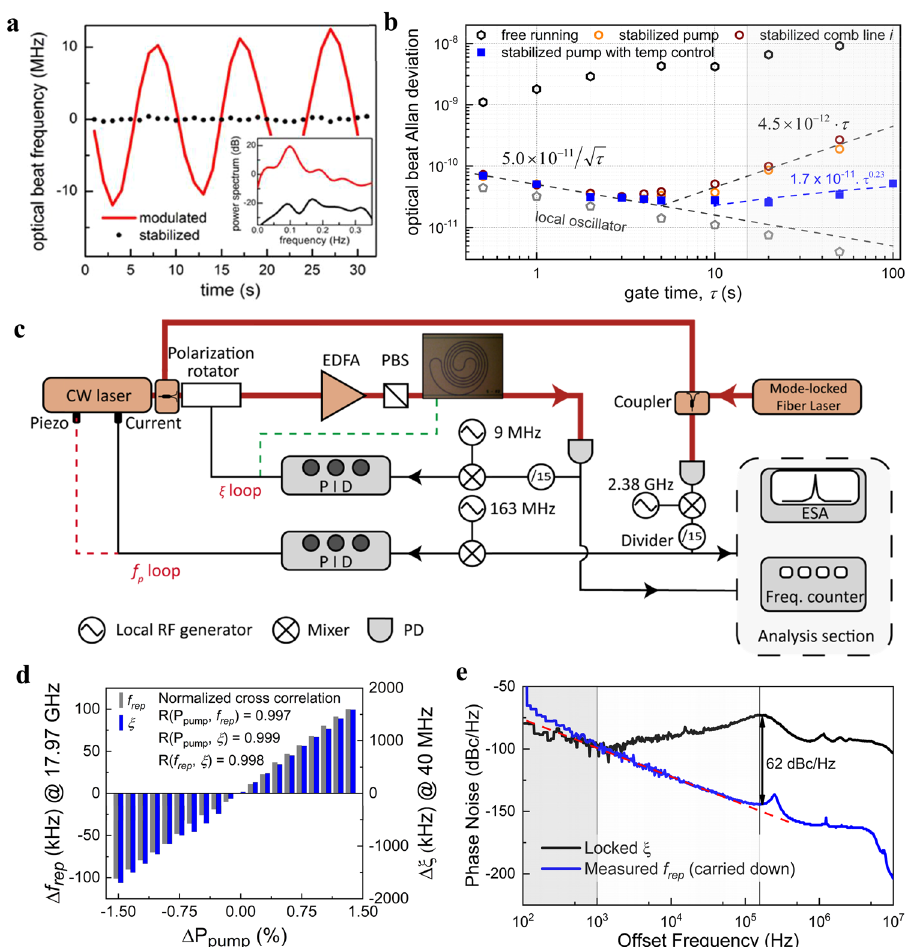
Fig. 4 Characterization of fully-locked comb stability and low-noise microwave generation. a Optical beat frequency between the pump and the stabilized fi ber frequency comb (FFC). With both the f rep and ξ phase-locked loops engaged, the arti fi cially introduced pump frequency perturbation (red curve) is suppressed and the optical beat frequency remains constant (black curve). The inset plots the corresponding power spectral densities, showing a more than 20 dB pump frequency noise suppression by the stabilization loops. b Free-running comb Allan Deviation (AD) is plotted with black hexagons. The orange and brown circles plot the AD of the pump and i th comb line, respectively, when stabilized with slow feedback to the preamp (yellow path in Fig. 2a). No apparent difference is observed between the ADs of the two comb lines 43 nm apart, indicating a good coherence transfer across the microcomb. Our measured values are close to the local oscillator AD (gray pentagons) used to stabilize f rep . For longer gate times, ADs show a characteristic linear dependence on the gate time, attributed to the uncompensated ambient temperature drift. To mitigate this, improved environmental isolation and partial compensation of ambient temperature drift (via green path in Fig. 2a) are implemented and AD of stabilized pump with is plotted in blue squares. The AD is improved to 2 × 10 − 11 at 20-s gate time, and slope of AD increase is reduced from τ to τ 0.23 . The shaded region on the right marks the point where slow thermal drift degrades the lock performance. c The setup schematic to generate low-noise microwaves. The pump laser is directly locked to an optical reference, in this case, a fully stabilized FFC referenced to an ultrastable cavity. Subsequently the offset ξ is also locked via feedback to pump power (through the action of the polarization rotator and PBS). The above-mentioned loops indirectly lock f rep due to suppression of both pump frequency noise and power fl uctuations. Slow feedback is sent to the temperature of the chip mount via a TEC to partially suppress ambient thermal drift. d f rep is plotted in the black bars and ξ is plotted in blue. Both f rep and ξ are strongly correlated with pump power, with measured correlation greater than 0.997. The absolute and frequency sensitivity to pump power are, respectively, ≈ 15 and ≈ 6,700 times larger for ξ than f rep . e Locking of both ξ and pump frequency allows for suppression of f rep noise (also see Supplementary Note VII). Here, the phase noise of the locked ξ (at 40 MHz) is plotted in black and the measured f rep , after engaging both feedback loops (and carried down to 40 MHz), is plotted in blue. We observe a 62 dB suppression of noise at high offset frequencies matching well with our expectations, in the unshaded region to the right; however, at lightly shaded region in the center uncompensated 1 / f 2 thermal noise (plotted in the dashed red line) begins to dominate and eventually surpasses the locked signal in the shaded region on the left. We can mitigate the effect of this thermal noise via better environmental isolation or passive cavity temperature